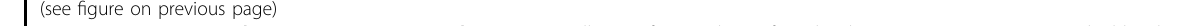
Fig. 2 FN-EDA promoted angiogenesis in vivo and vitro. A Overall view of mouse liver infected with AAV9 (Green: EGFP). Six-week-old male wild- type C57BL/6 mice were intraperitoneally injected with 20% CCl 4 dissolved in olive oil, or olive oil alone twice a week (2 ml/kg) for 8 weeks. AAV9 control vector (AAV9-Ctrl) or AAV9-FN-EDA-shRNA were injected into mice through tail vein at the beginning of week 1 and week 5. Mouse livers were harvest at the end of week 8. (Scale bar = 2.5 mm.) B Immuno fl uorescence staining of FN-EDA, α -SMA and CD31 in AAV9-FN-EDA-shRNA or AAV9-Ctrl infected mice with experimental hepatic fi brosis ( n = 3). (Arrows: staining. Data are shown as mean ± SEM. FN-EDA: *** P < 0.0001; α -SMA: * P < 0.01; CD31: ** P < 0.001. Scale bar = 200 μ m.) C Immunoblot analysis of FN-EDA, α -SMA and CD31 in AAV9-FN-EDA-shRNA or AAV9-Ctrl infected mice with experimental hepatic fi brosis (n = 3). (Data are shown as mean ± SEM. α -SMA: *** P < 0.0001; FN-EDA: *** P < 0.0001; CD31: ** P < 0.001.) D Mouse experimental hepatic fi brosis samples were processed for immuno fl uorescence co-staining for FN-EDA (red) with α -SMA (activated HSC marker), CD31 (endothelial marker), and Alb (hepatocyte marker) (green). Nucleus were counterstained with DAPI. (Arrows: co-staining. Scale bar = 100 μ m.) E Immunoblot result of FN-EDA in LX-2 cells and its supernatant. LX-2 cells were transfected with two FN-EDA-siRNAs or Ctrl-siRNA